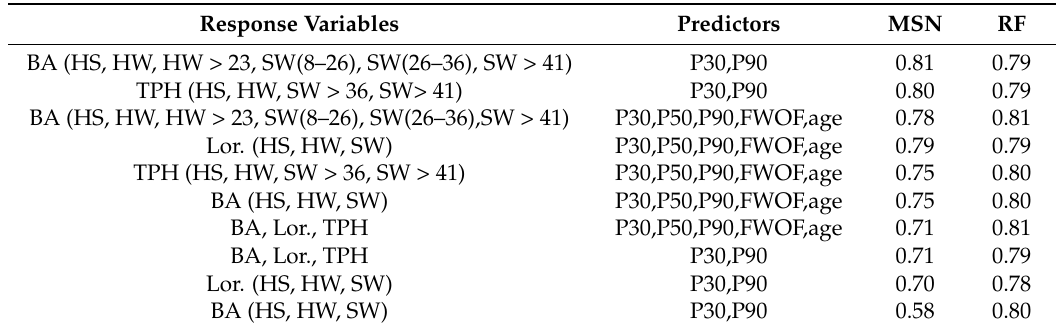
Table 6. Index H values for k-NN (k = 3) dbh predictions for selected predictor and response sets for all species combined.